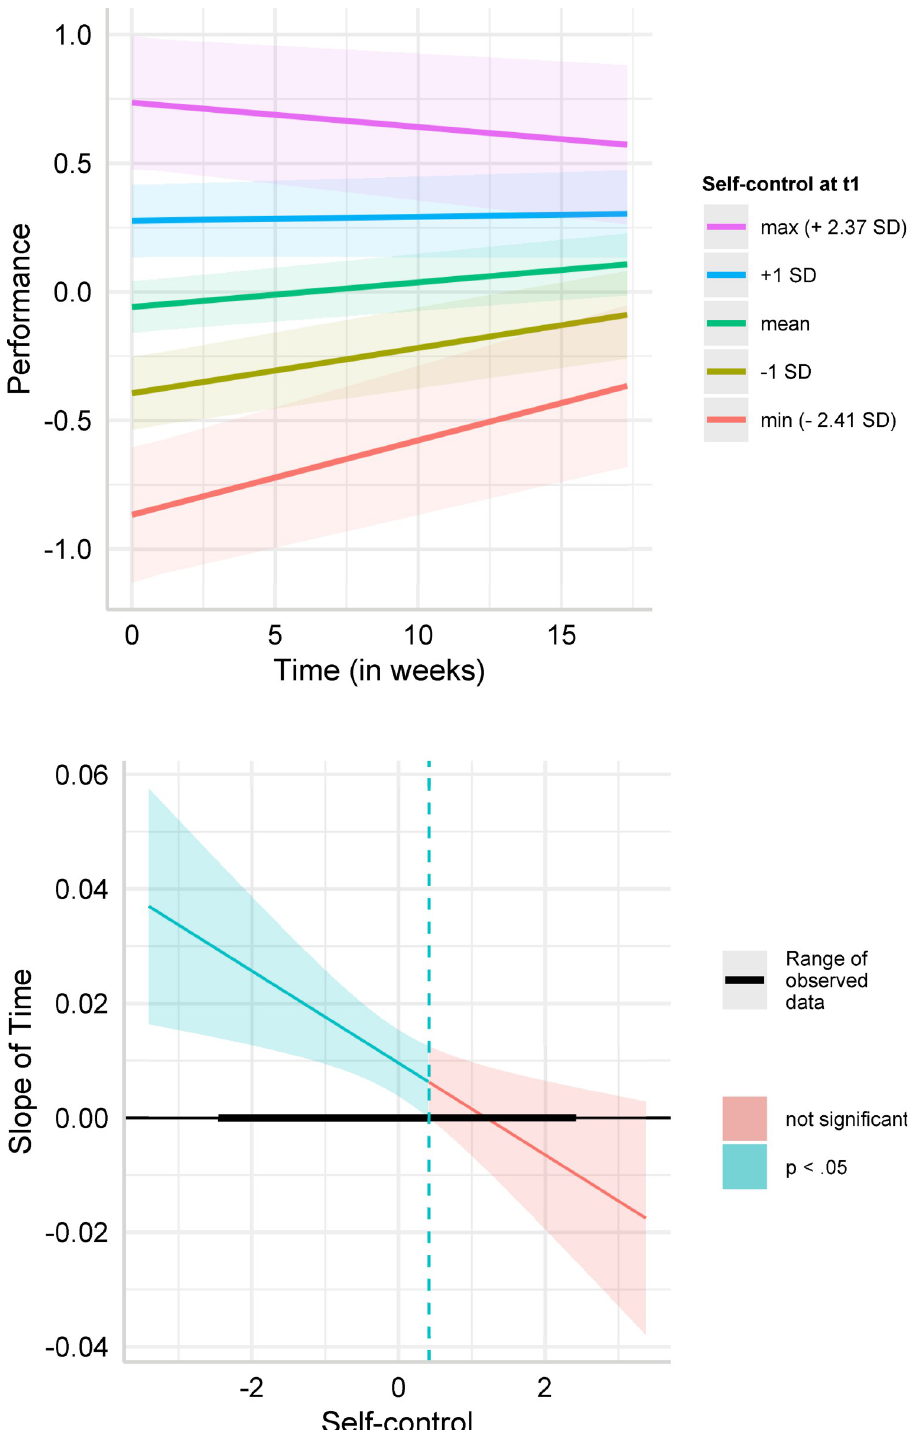
Fig 2. A. Predicted values of performance. Simple slope estimates for Model 1 (dependent variable: performance) in Table 4. The figure depicts predicted values of performance (standardized around 0) over time for low self-control (-1 SD below mean), average self-control, high self-control (+1 SD above mean) individuals, minimum self-control in the sample (-2.41 SD), and maximum self-control in the sample (2.37 SD). B. Johnson-Neyman intervals for performance. Johnson-Neyman intervals for the simple slope estimates for Model 1 (dependent variable: performance) in Table 4. The figure depicts the estimated slope of time for each level of trait self-control (standardized around 0) and highlights for which values of trait self-control the simple slope estimate is